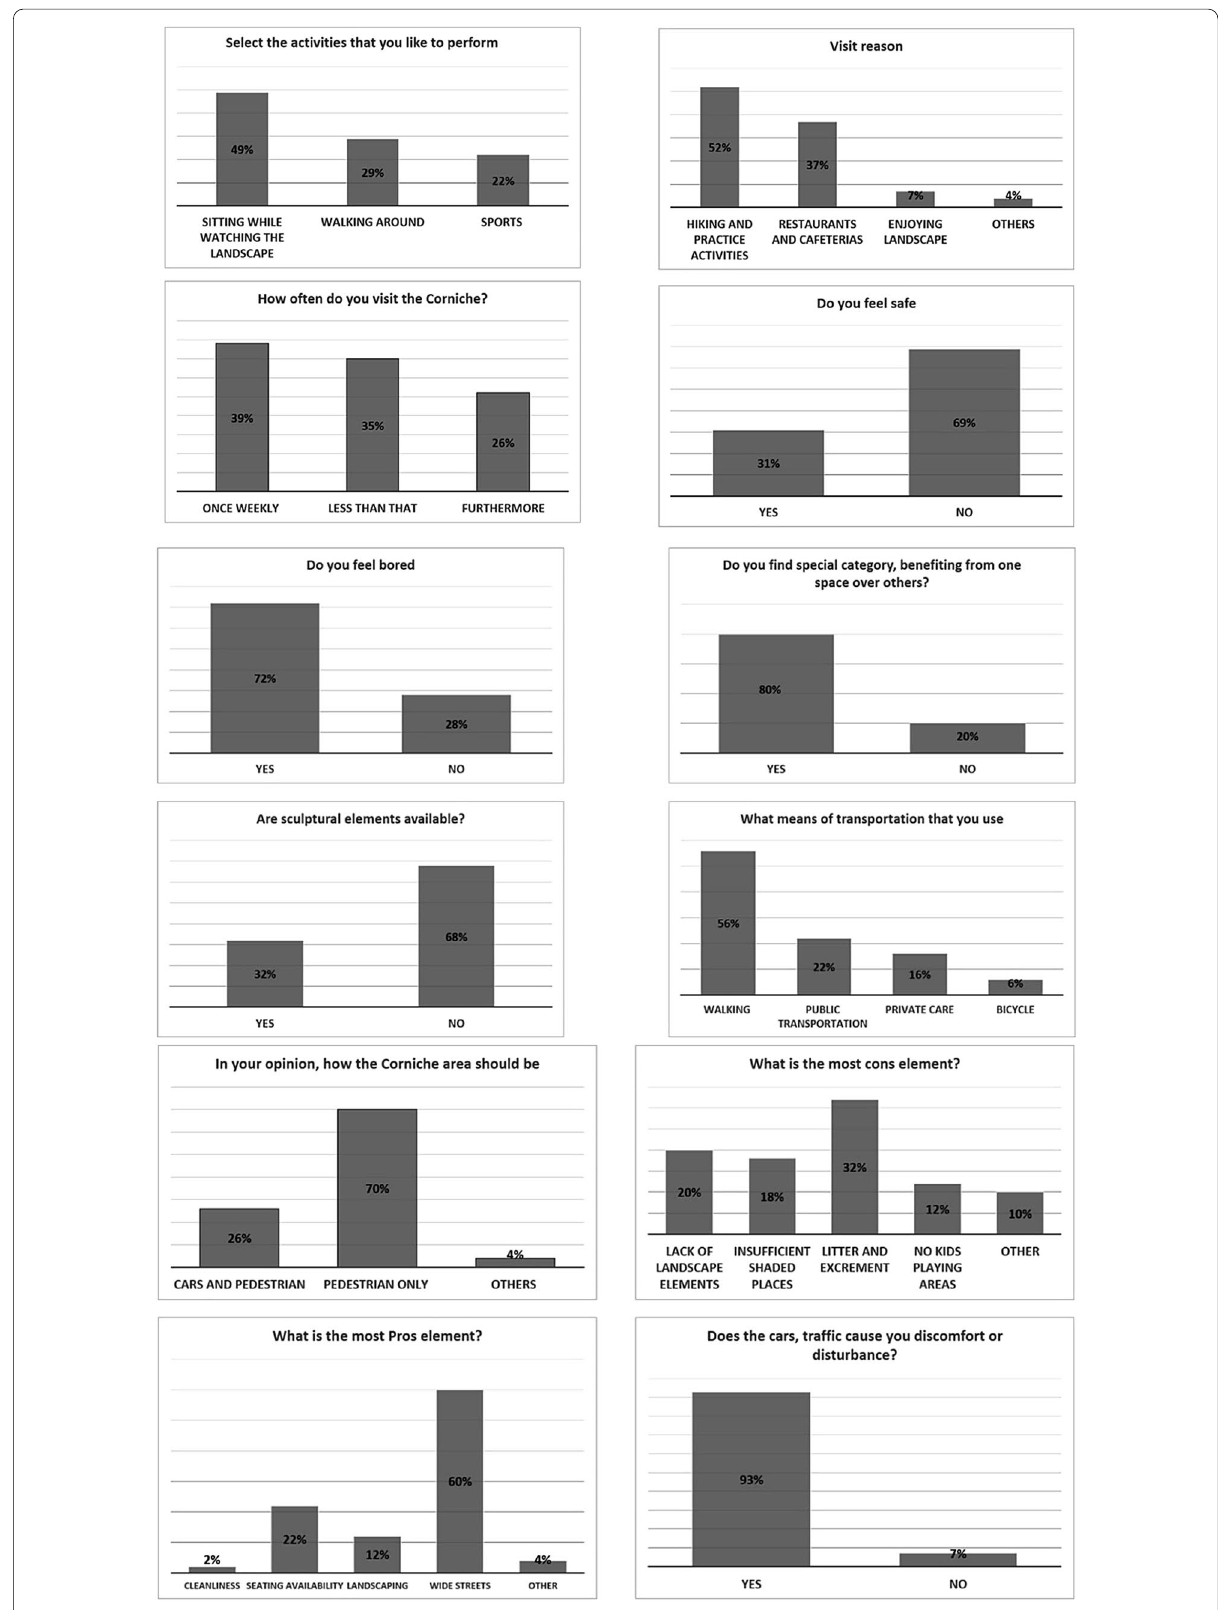
Fig. 4 Questionnaire analysis results, Source: The